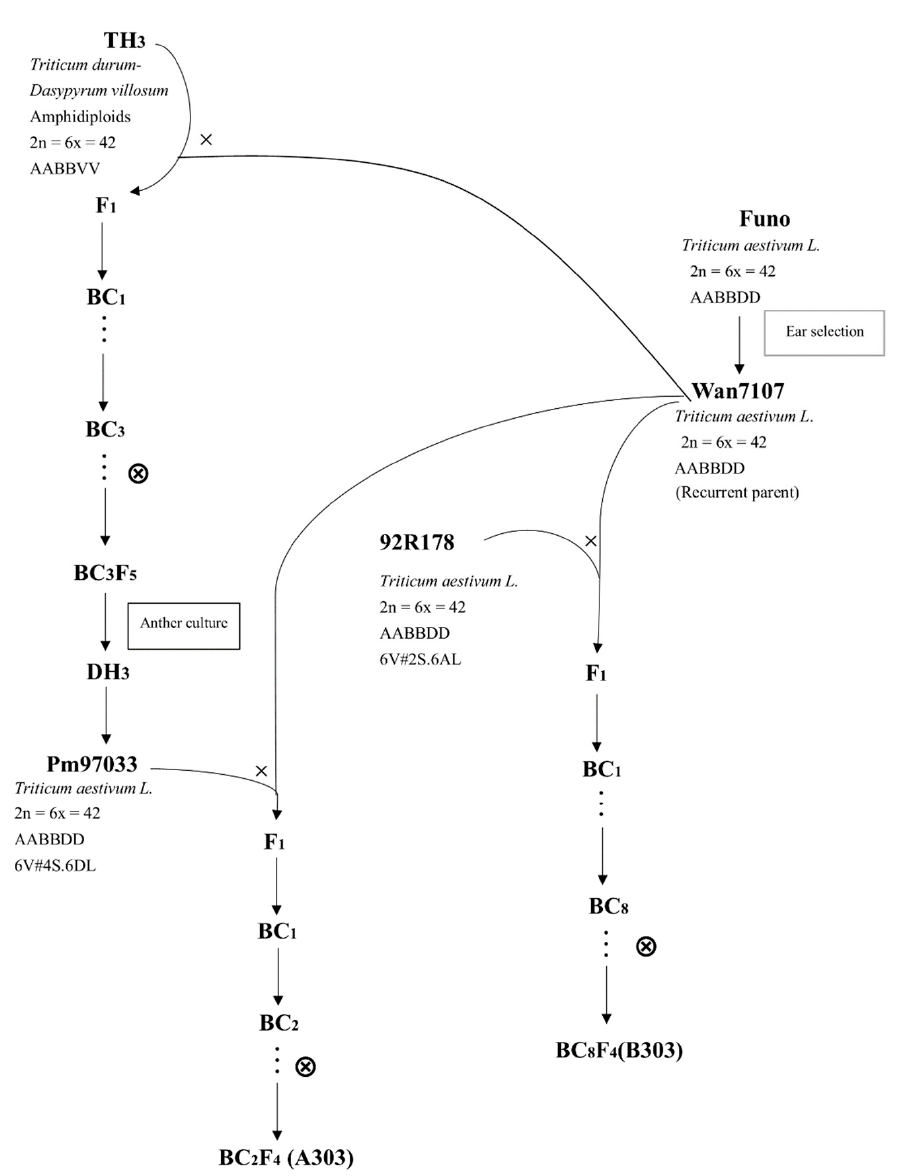
Figure 1. Genealogical diagram of the materials in this study.